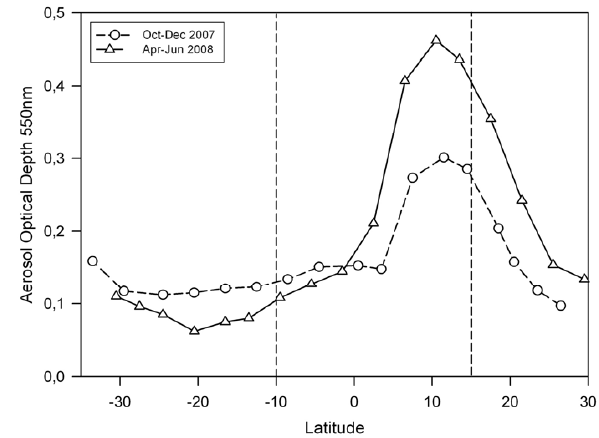
Fig. 5. Latitudinal distribution of seasonal aerosol optical depth at 550nm (AOD 550nm) derived from Aqua-MODIS satellite during the 2007 (circles) and 2008 (triangles)